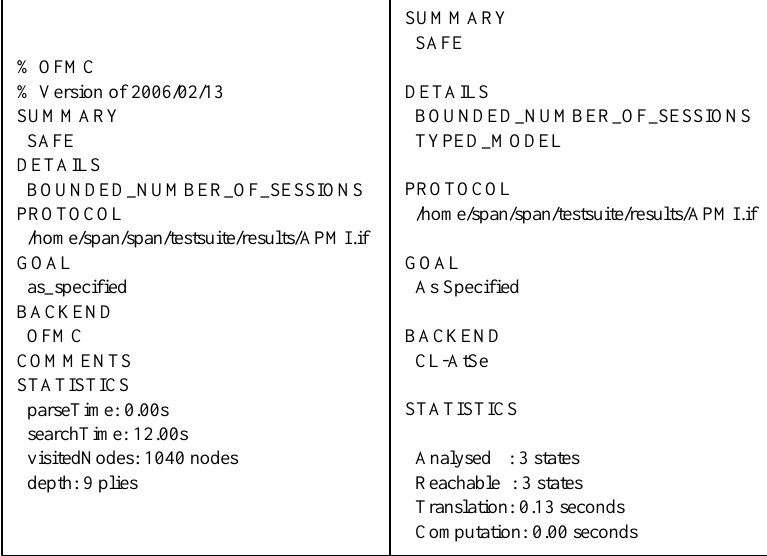
Figure 12. The result of Automated Validation of Internet Security Protocols and Applications (AVISPA) simulation using OFMC and CL-AtSe.